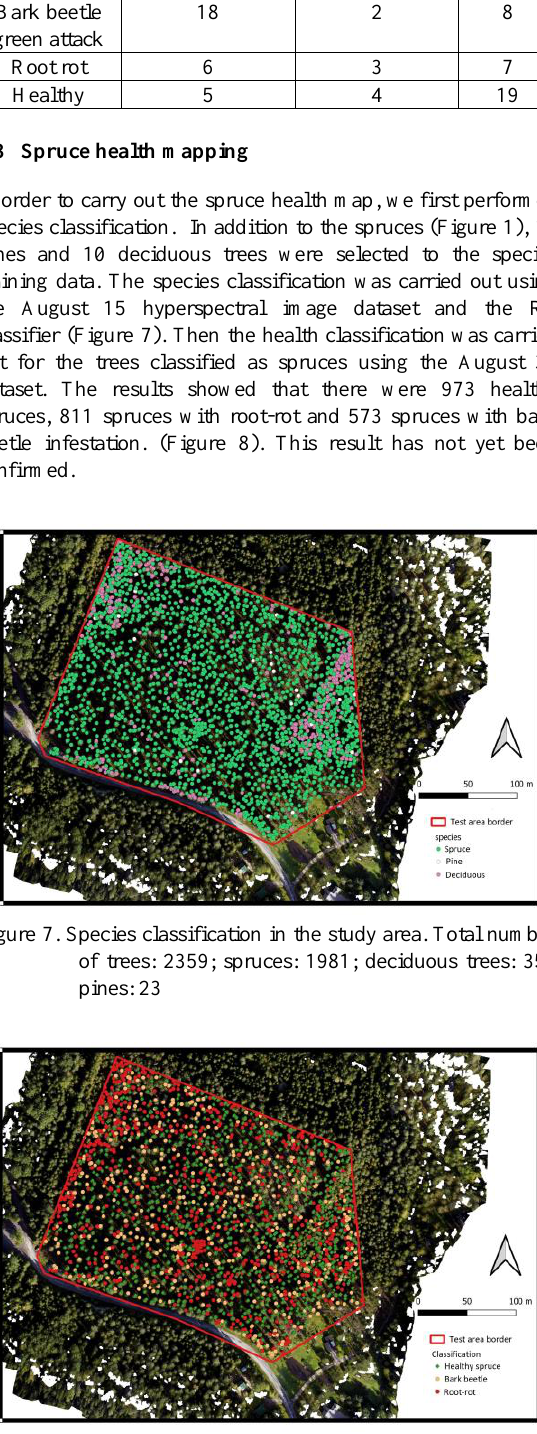
Figure 8. Health classification of spruces in the test